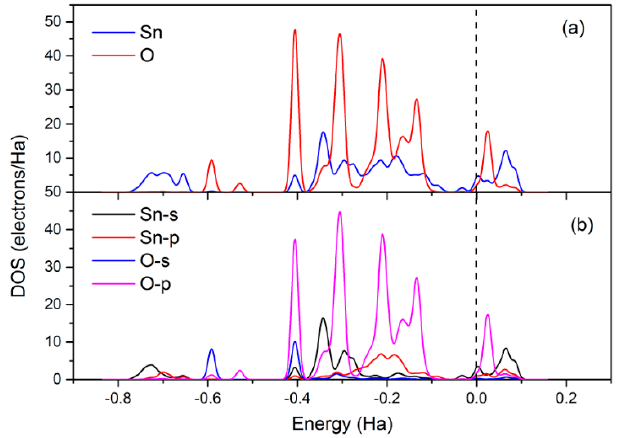
Figure 15. The ( a ) total density of states (DOSs) and ( b ) partial density of states (PDOSs) of O (originating from acetone) and Sn. The vertical dotted line indicates the Fermi energy level.